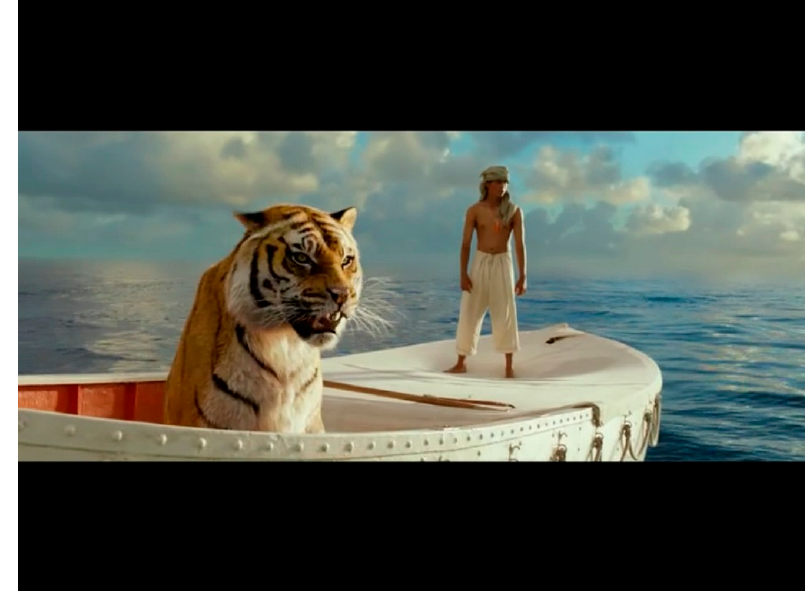
Figure 12. Pi’s relationship to the tiger is mirrored in the visual effects of sky and sea.